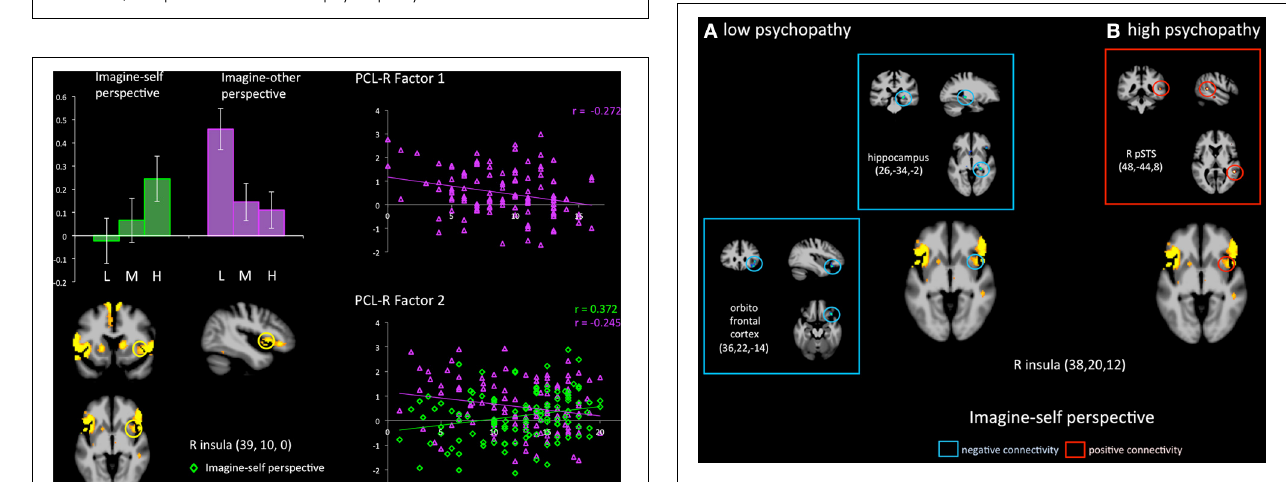
FIGURE 2 | Response in the right anterior insula across groups (L, low; M, medium; H, high on total PCL-R scores) during imagine-self and imagine-other perspectives in participants viewing bodily injuries. Groupwise effects seen in (bar graph) are expanded to show the contribution of Factors 1 and 2 from PCL-R subscores.